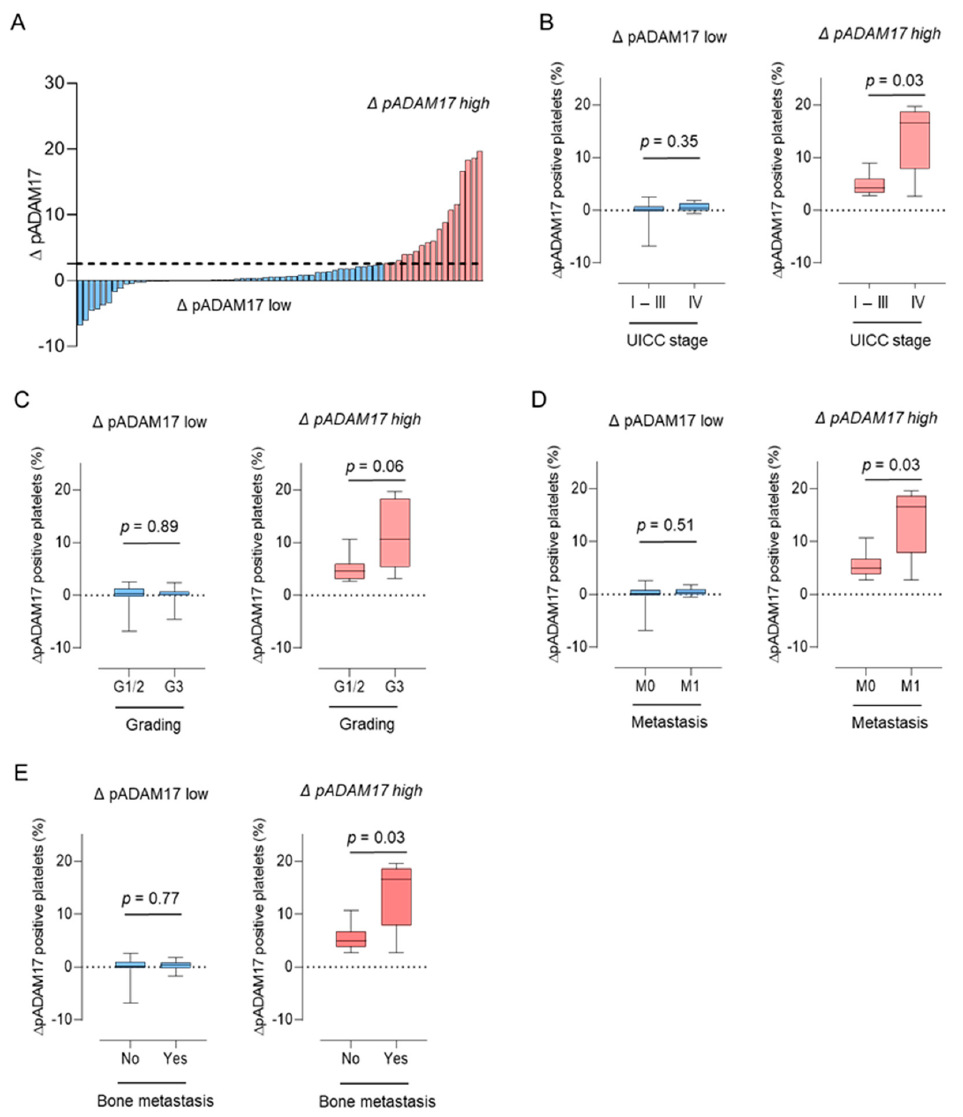
Figure 3. Correlation of pADAM17 downregulation ( ∆ pADAM17) with clinical parameters in our breast cancer cohort. ( A ) Extent of ∆ pADAM17 (defined as “the percentage of ADAM17 positive, CD62P negative platelets—the percentage of ADAM17 positive, CD62P positive platelets”). The 75th percentile is regarded as ∆ pADAM17 high (red), all other values are defined as ∆ pADAM17 low (blue). ( B – E ) Association of high ∆ pADAM17 with Union for International Cancer Control (UICC) stage ( B ), G grade ( C ), the occurrence of metastasis (M stage) ( D ), and bone metastasis ( E ).